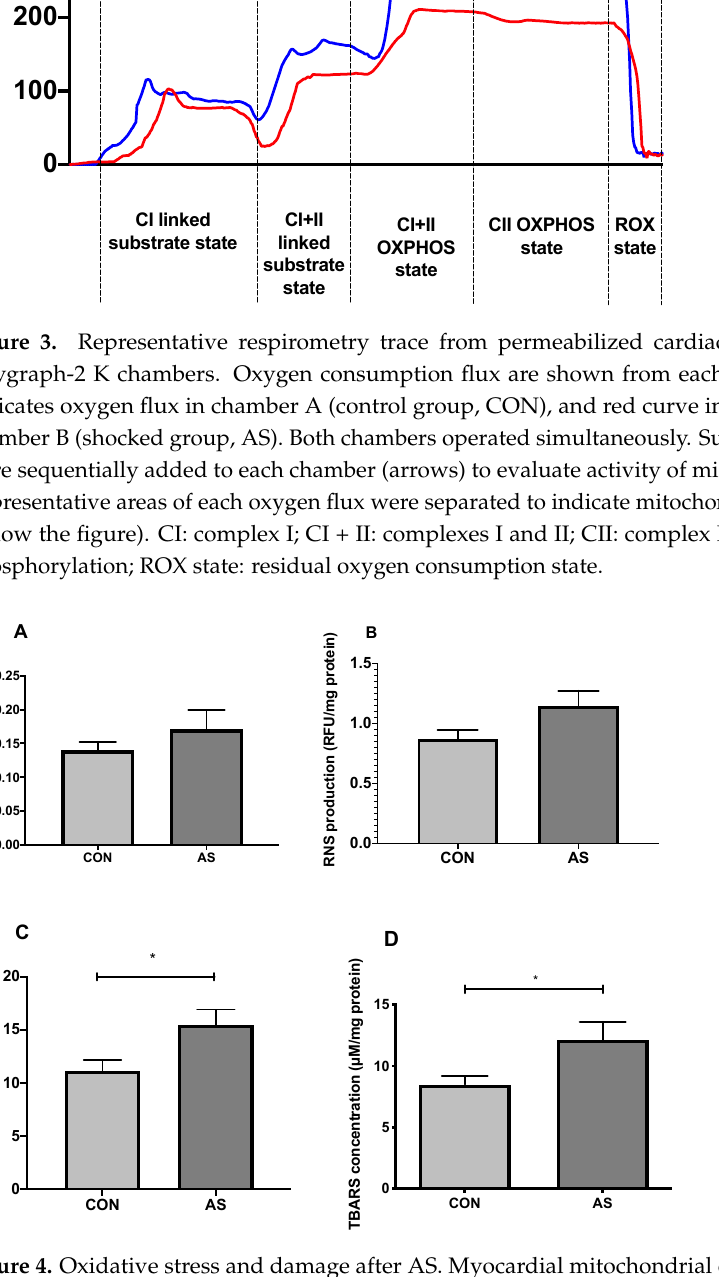
Figure 4. Oxidative stress and damage after AS. Myocardial mitochondrial oxidative stress 15 min after AS onset with ROS production ( A ) was not significantly increased ( p = 0.62), and RNS production ( B ) tended to increase ( p = 0.07) in AS group. SODs activity ( C ) was significantly increased in AS group, which might explain the low rate of ROS in AS group. TBARs concentration ( D ) was significantly increased in AS group probably due to RNS-pathway with peroxynitrite. Results were expressed as mean ± SEM. * p < 0.05 compared to CON group. CON: control group, AS: shock group, ROS: reactive oxygen species, RNS: reactive nitrogen species, SODs: superoxide dismutases.